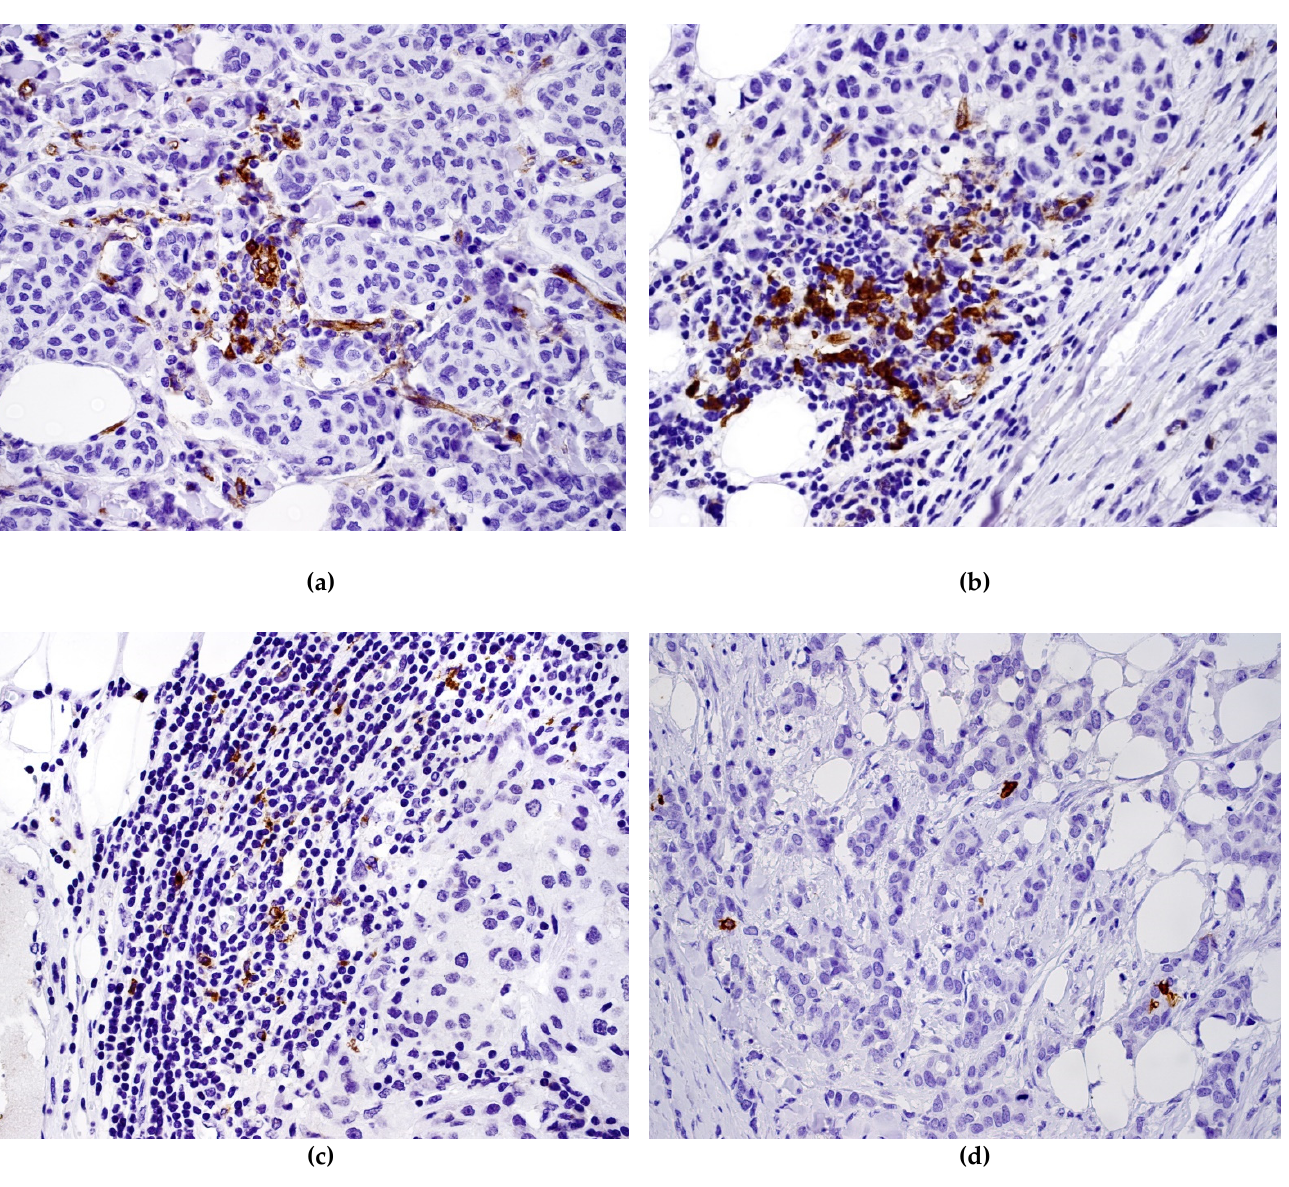
Figure 5. Dendritic cells in breast carcinoma: (a) intratumoural CD123+ cells, (b) invasive margin CD123+ cells, (c) LAMP3+ cells at invasive margin, (d) CD1a+.